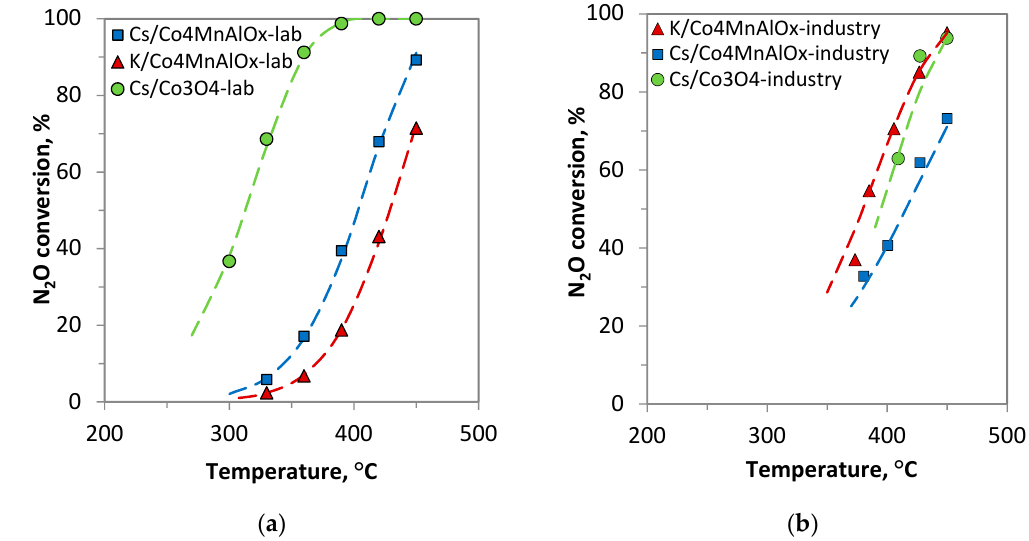
Figure 1. N 2 O catalytic decomposition over: ( a ) laboratory prepared catalyst grains in simulated process condition (1000 ppm N 2 O + 5 mol% O 2 + 2 mol% H 2 O in N 2 , GHSV = 60,000 l kg − 1 h − 1 ); ( b ) commercially prepared catalyst tablets in real waste gas (VHSV = 11,000 m 3 m bed − 3 h − 1 , real waste gas (512 ± 135 ppm N 2 O, 26 ± 16 ppm NO x , 9 ± 3 ppm NH 3 , p = 0.6 MPa). Points—experimental data; dashed line—model (Equation 2).